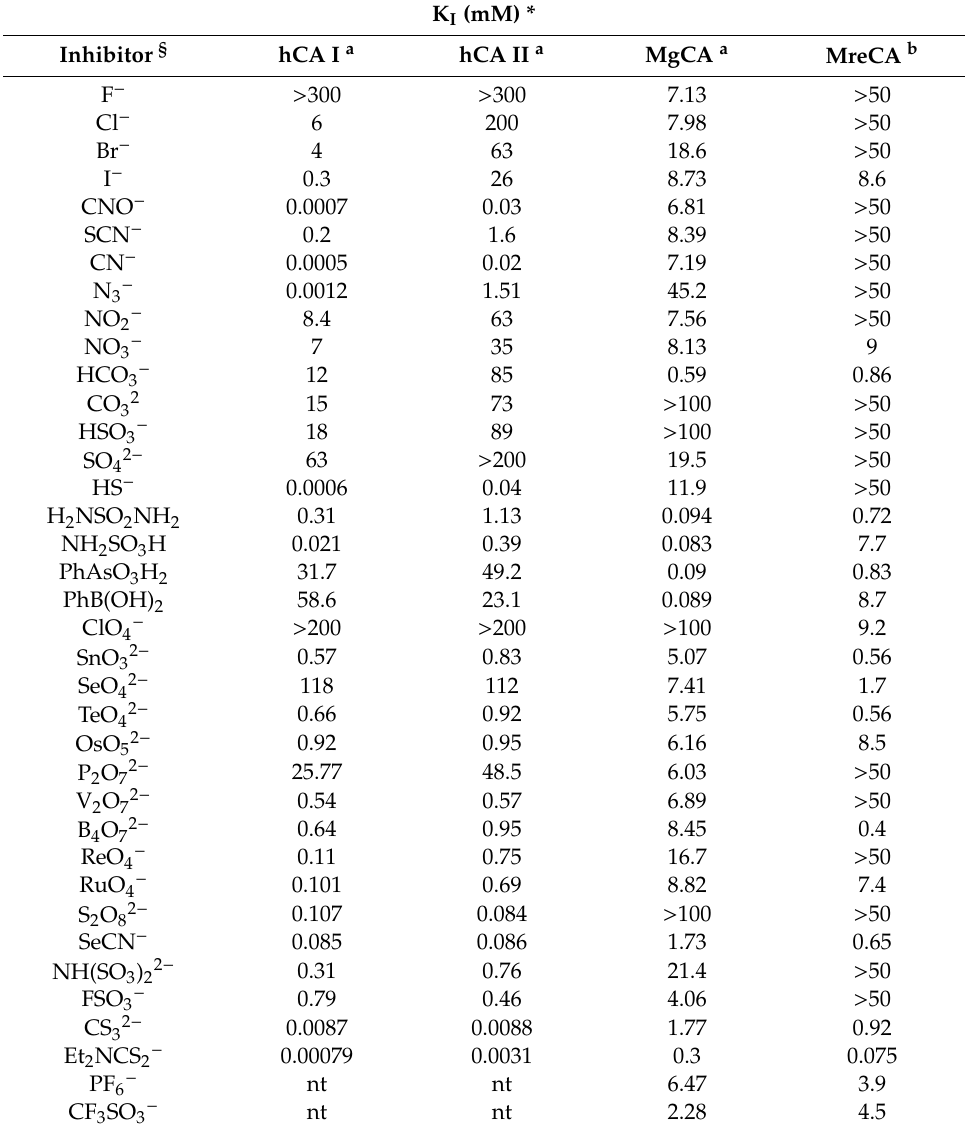
Table 1. Inhibition constants of anionic inhibitors against the α -CAs isoform (hCA I and hCA II) and the β -CAs from M. globosa and M. restricta (MgCA and MreCA) for the CO 2 hydration reaction, at 20 ◦ C and pH